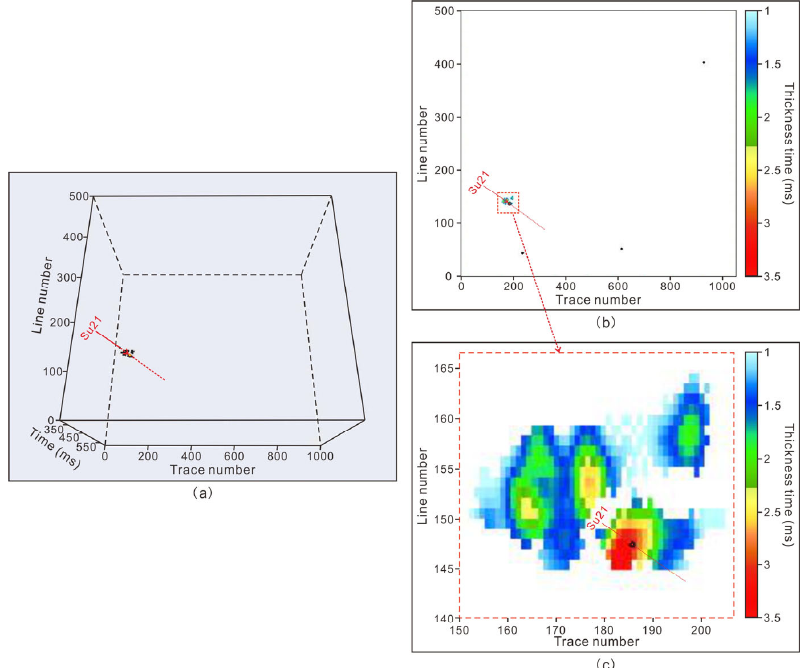
Figure 11. The 3D spatial range and its plane distribution characteristics along the target stratum of the sand body with uranium around Well Su21: ( a ) 3D spatial range, ( b ) Plane distribution characteristics extracted along the target stratum, ( c ) Local enlargement of the red rectangular dashed box in ( b ).